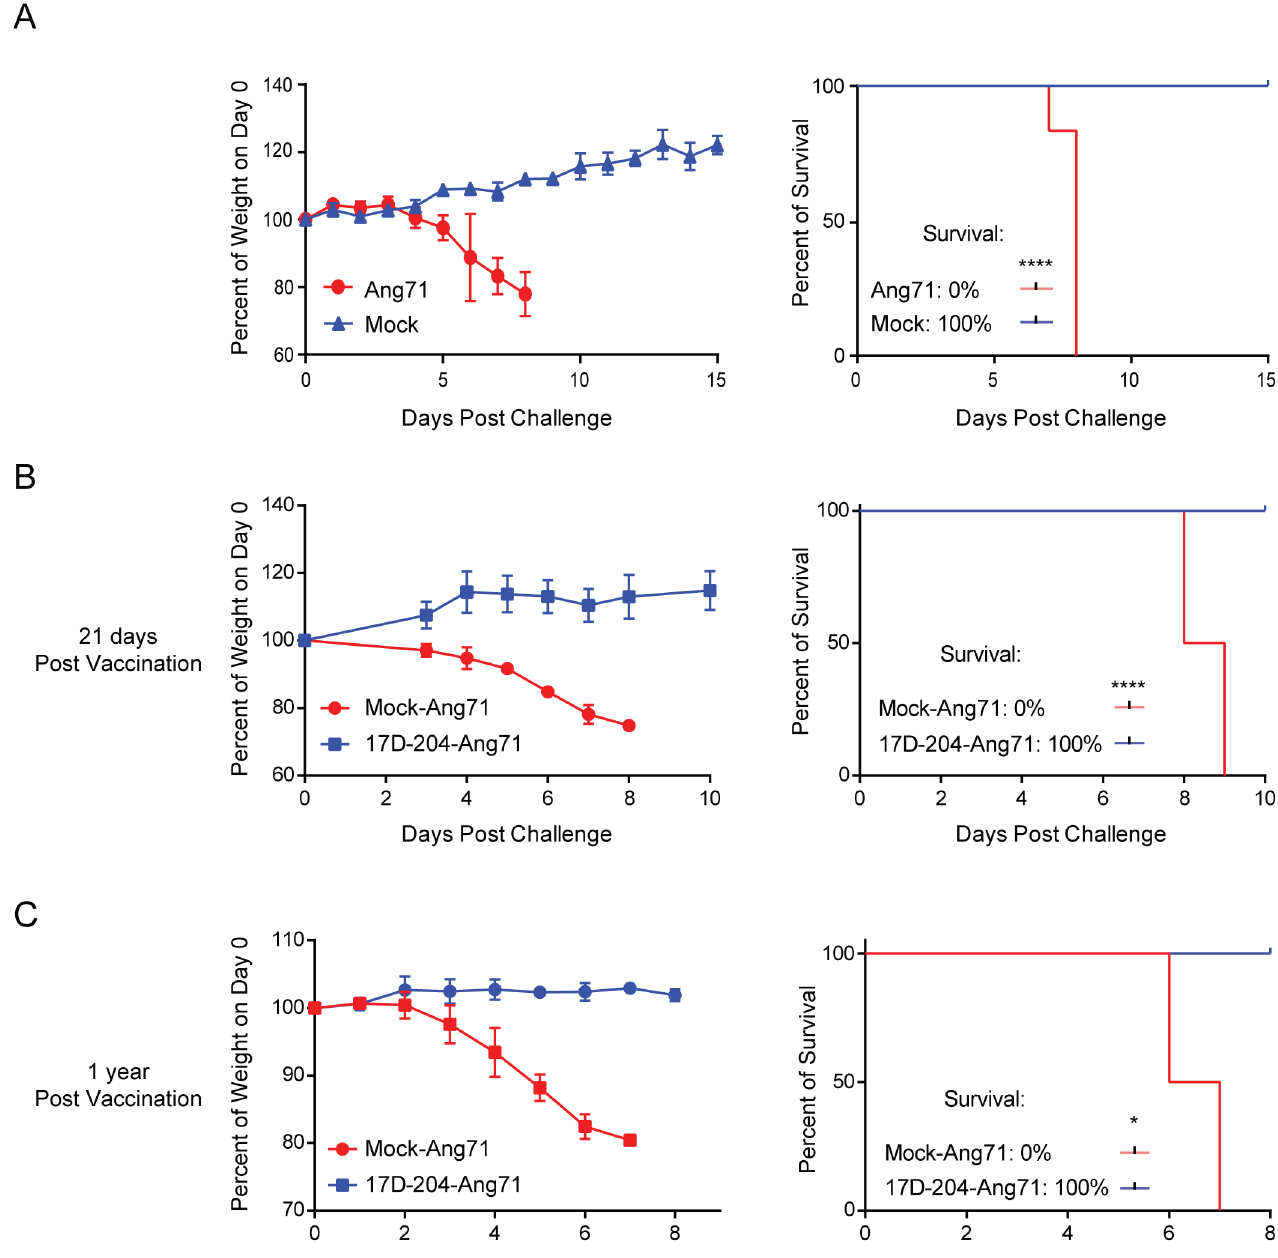
Fig 2. Immunization with 17D-204 protects mice against challenge with virulent wtYFV. (A) 5 – 6 week old mice were infected with Ang71 and monitored daily for weight and survival (mock, n = 5; Ang71, n = 10). (B and C) At 5 weeks of age, mice were infected with 17D-204 and on (B) d21 (Mock-Ang71, n = 7; 17D-204-Ang71, n = 12) or (C) 1 year (Mock-Ang71, n = 3; 17D-204-Ang71, n = 2) following vaccination, mice were challenged with Ang71 and monitored daily for weight and survival. Euthanasia was carried out according to preapproved weight loss and morbidity criteria. Weight is expressed as a percentage of weight on d0 of challenge with Ang71. The results in A and B are representative of two independent experiments. C was completed one time. Weights are displayed as mean ± SD. Statistical independence of surviving mice versus euthanized mice was calculated using a one-tailed chi-squared test ( * , p (cid:1) 0.05; **** , p < 0.0001).